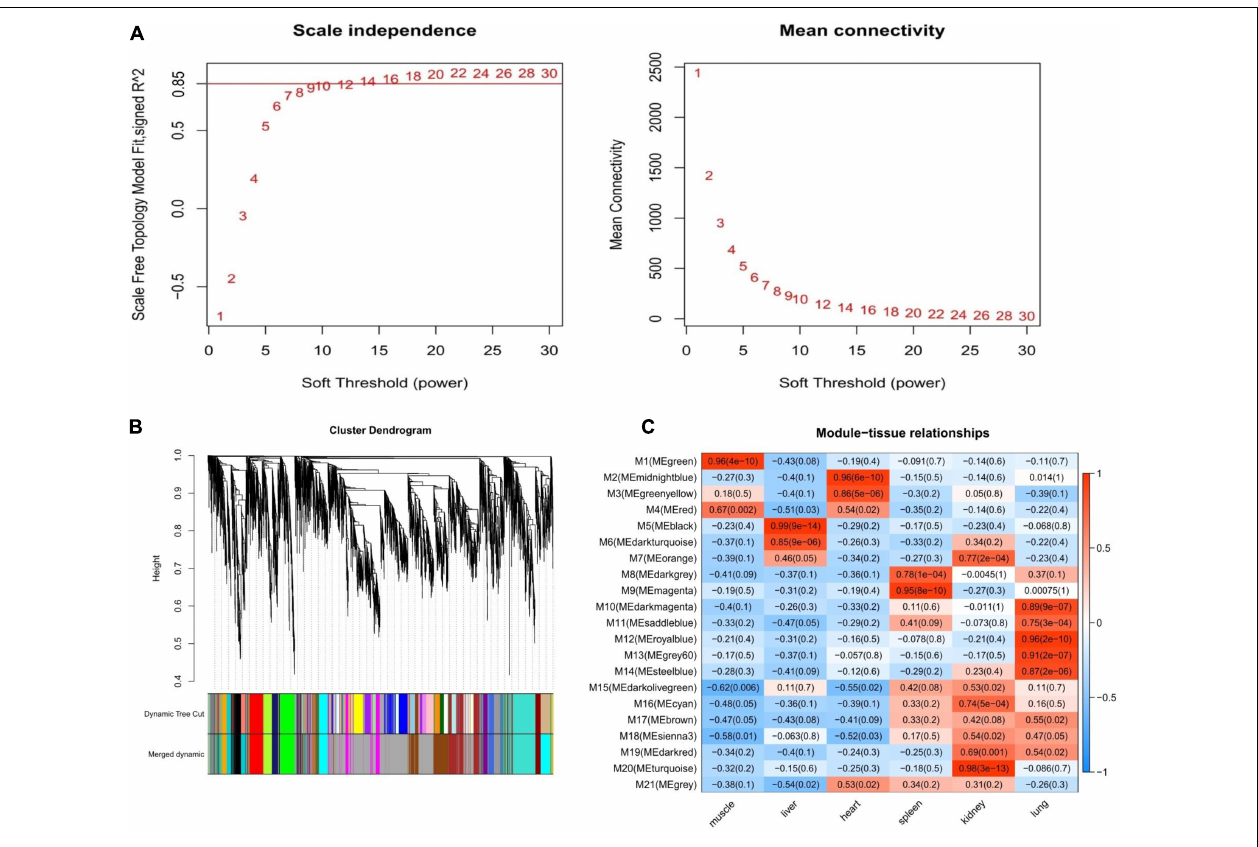
FIGURE 3 | Weighted gene co-expression network analysis of Tibetan pigs. (A) Network topology of different soft-thresholding power of Tibetan pig co-expression network. The left panel displays the influence of soft-thresholding power ( x -axis) on scale-free fit index ( y -axis). The right panel shows the influence of soft-thresholding power ( x -axis) on the mean connectivity (degree, y -axis). (B) Gene clustering module of Tibetan pig co-expression network. The dissimilarity was based on topological overlap. The “Merged dynamic” is the result of merging modules with a correlation higher than 0.9. The y -axis is the distance determined by the extent of topological overlap. (C) Heatmap of the correlation between module eigengenes and the six tissues of Tibetan pigs. The x -axis is the six tissues of Tibetan pigs, and the y -axis is the module eigengene (ME). In the heatmap, red represents high adjacency (positive correlation), and blue represents low adjacency (negative correlation). In brackets is the p -value of the correlation